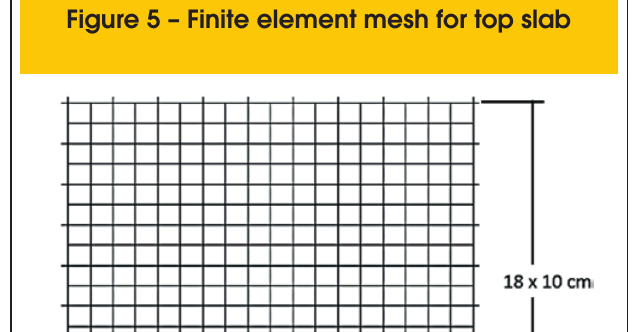
Figure 5 – Finite element mesh for top slab